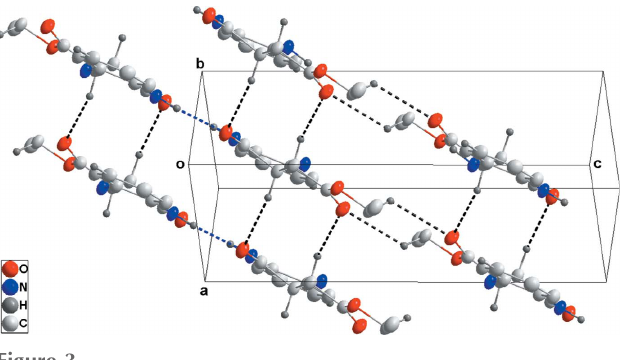
Figure 3 Elevation view of the stacked layers with hydrogen bonds shown as in Fig. 2.